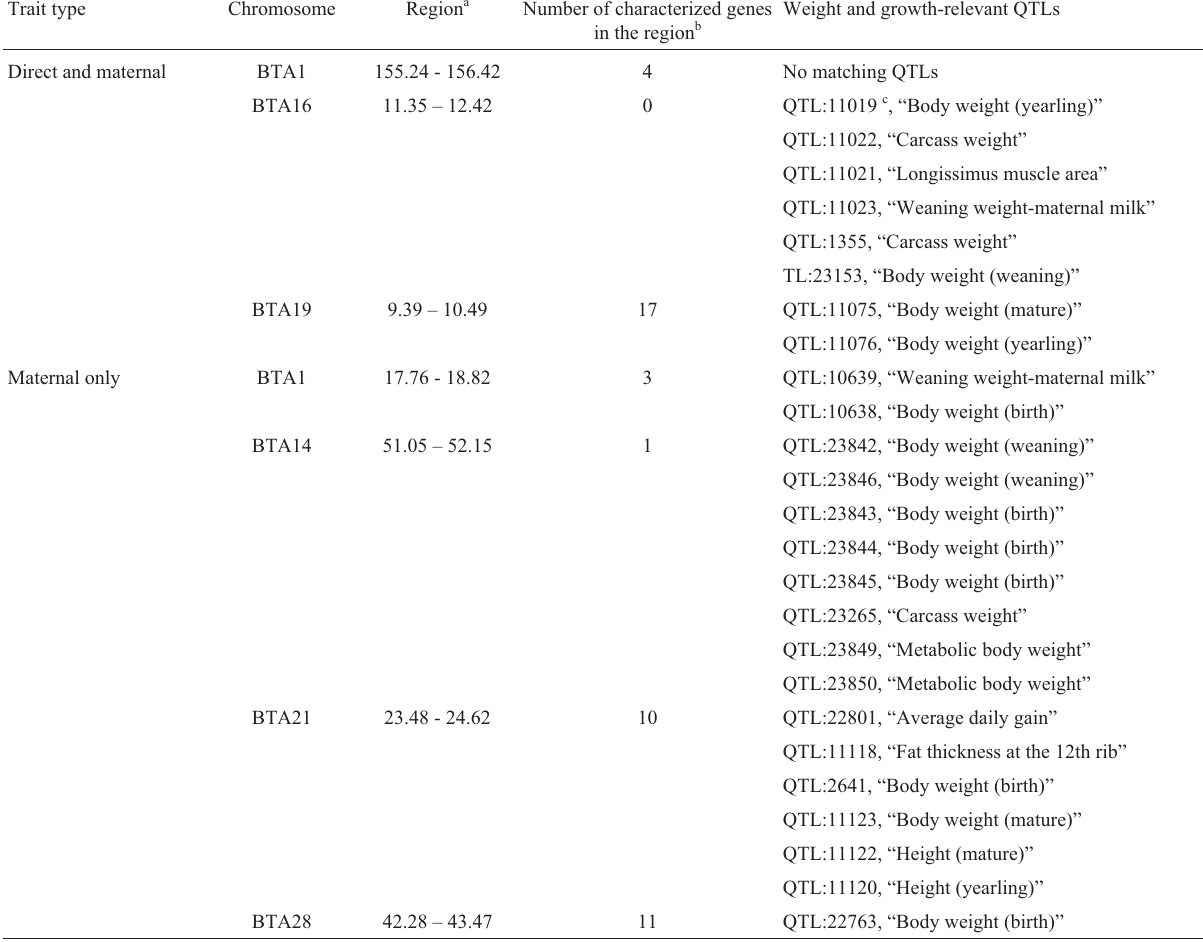
Table 4 - Most important regions of DNA related to yearling weight in Zebu Brahman breed. Trait